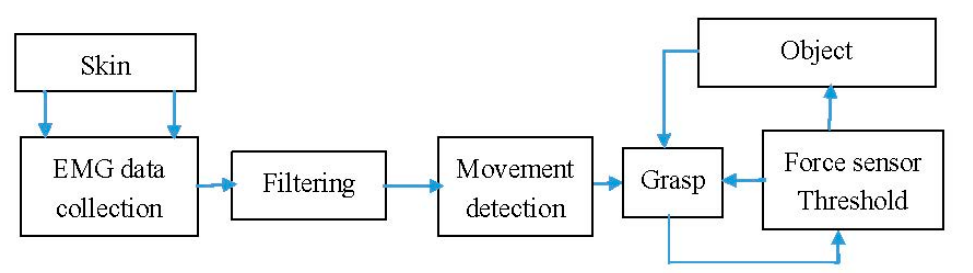
Figure 7. Motion sensing block diagram of the prosthetic hand.